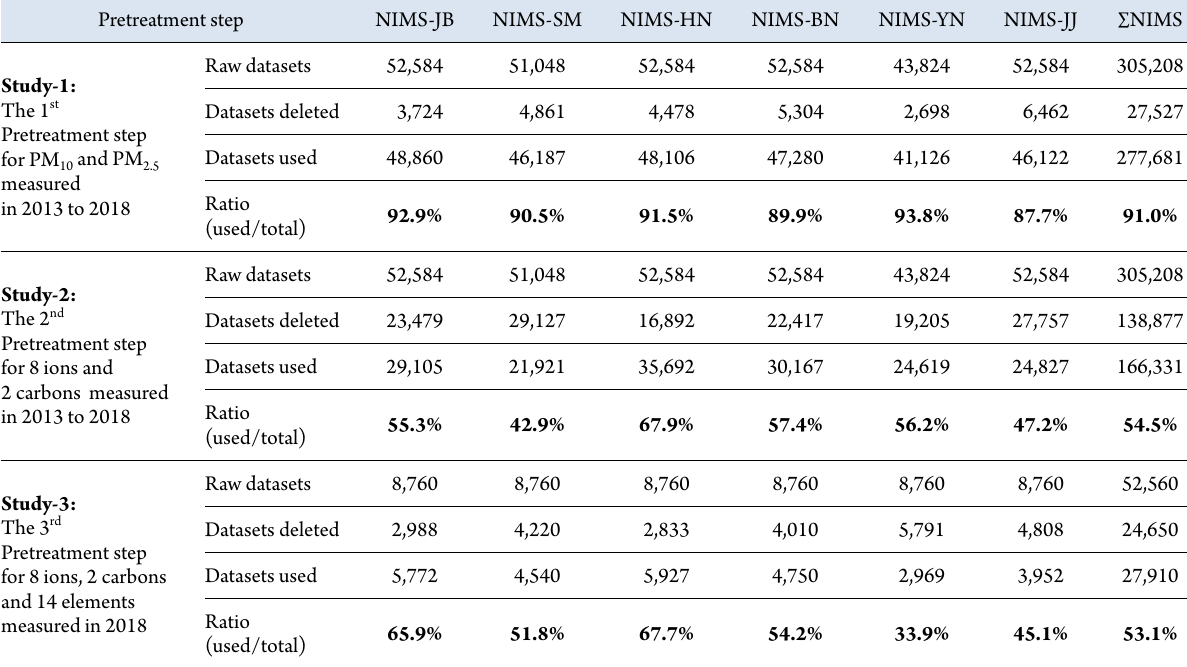
Table 2. Numbers of sample datasets deleted and used at each NIMS after data pretreatment. Pretreatment